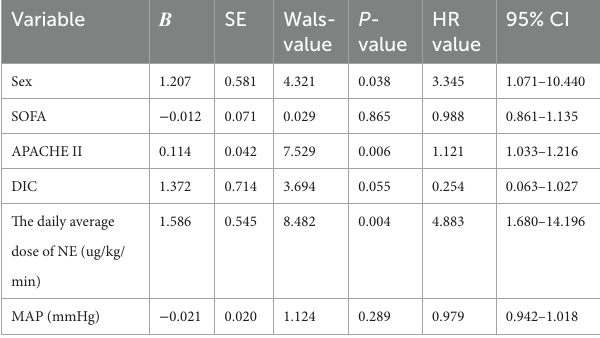
TABLE 3 Multivariate Cox regression analysis of prognosis related factors.